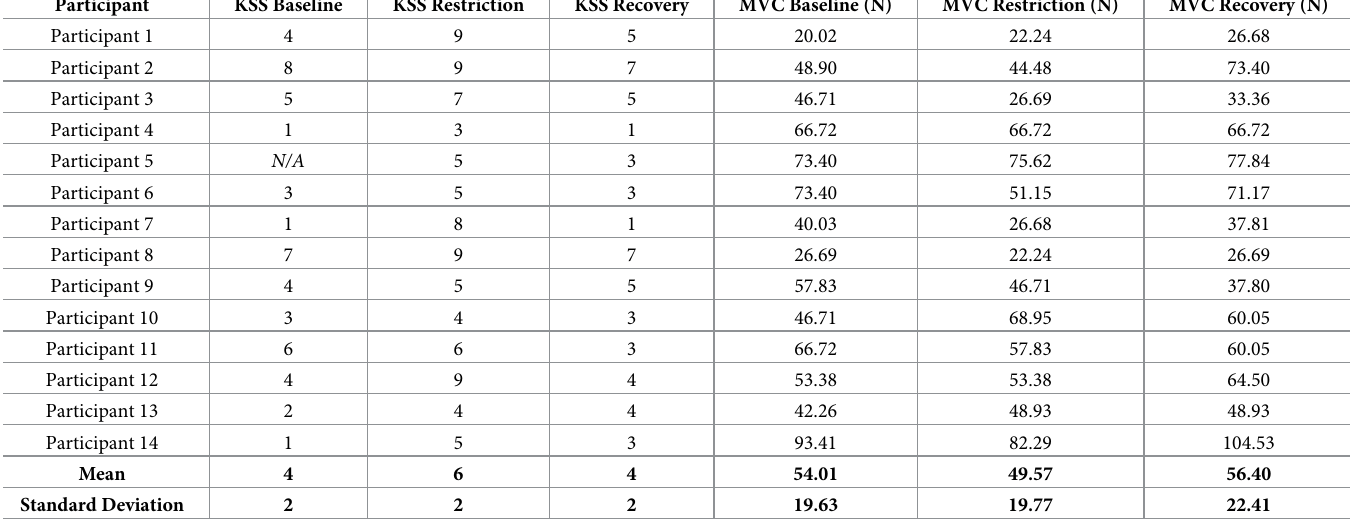
Table 1. Participant